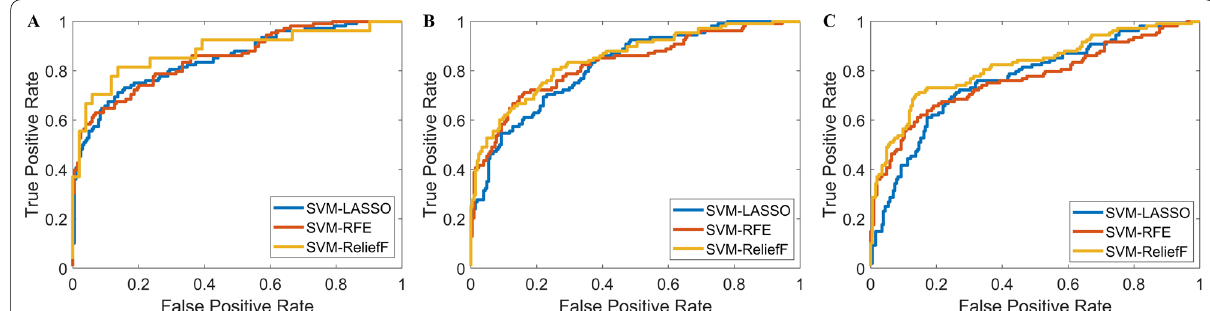
Fig. 4 Predictive performance of three machine learning algorithms: SVM-LASSO, SVM-RFE, and SVM-ReliefF. a Receiver operating characteristic (ROC) curve analysis for the training cohort. b ROC curve analysis for the validation cohort. c ROC curve analysis for the testing cohort